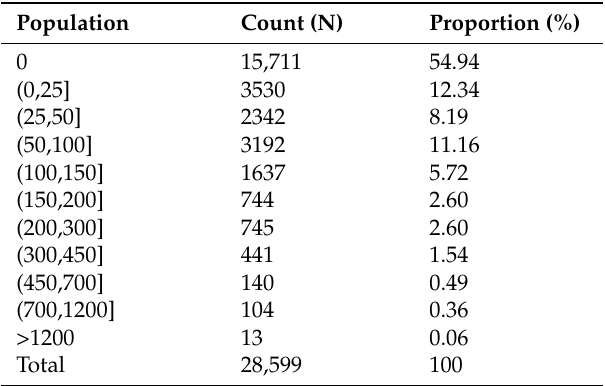
Table 5. Statistics of the 50-m Grid Population is obtained through counting the population spatialization results on the street